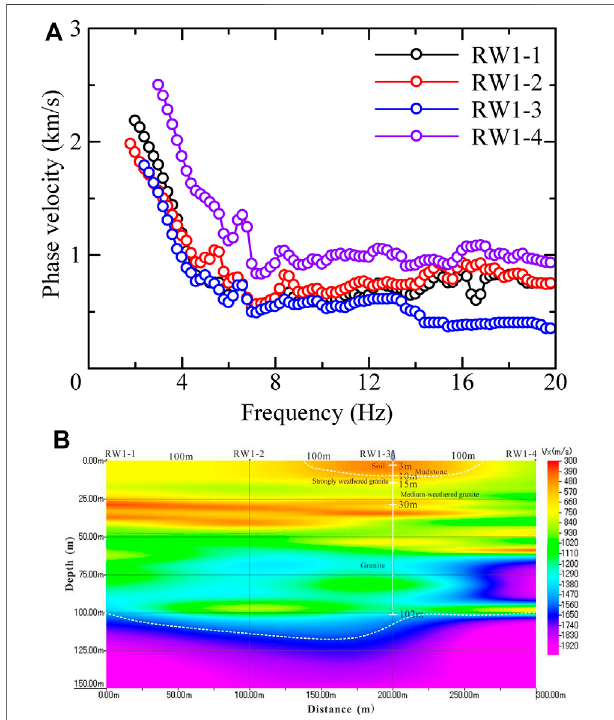
FIGURE6| Dispersioncurveofallthesurveypoints (A) and2Dapparent S-wave velocity section to track the irregular shapes of the cap layers or reservoirs (B)